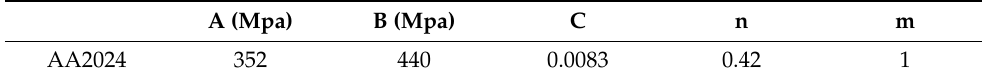
Table 3. J-C constitutive constants for AA2024. A (Mpa)